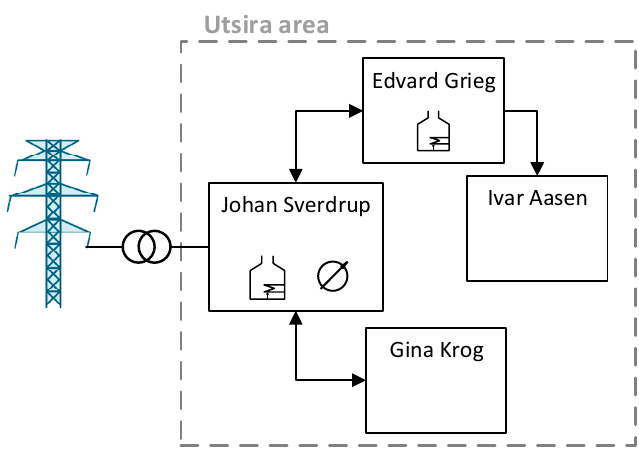
Figure 4. Scheme of Concept 1 —Full Electrification.